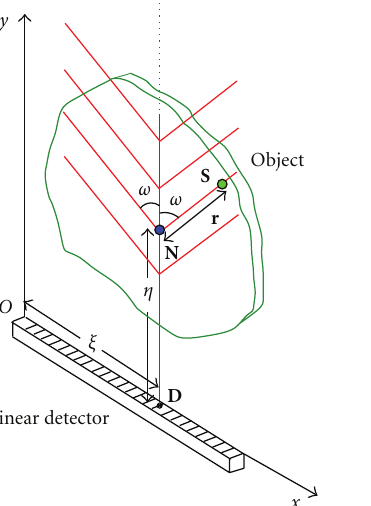
Figure 18: Setup and parameters of the compounded V-line Radon transform (CVLT).